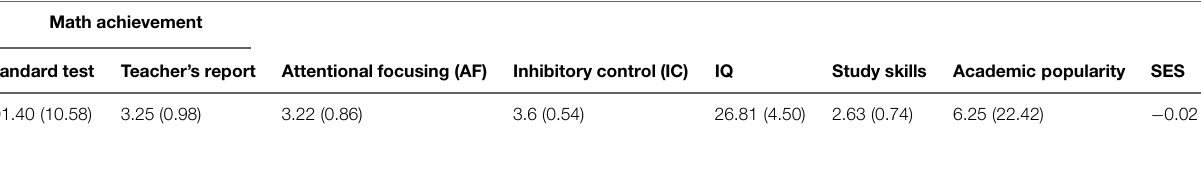
TABLE 1 | Means and SD (in parentheses) for the variables under